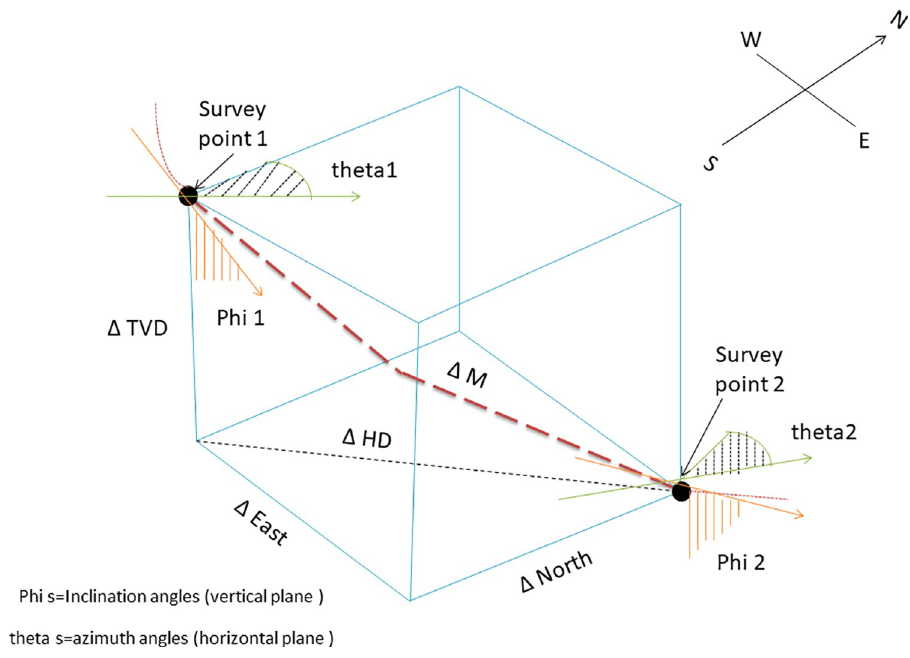
Fig 2. Offset distance of a typical directional wellbore